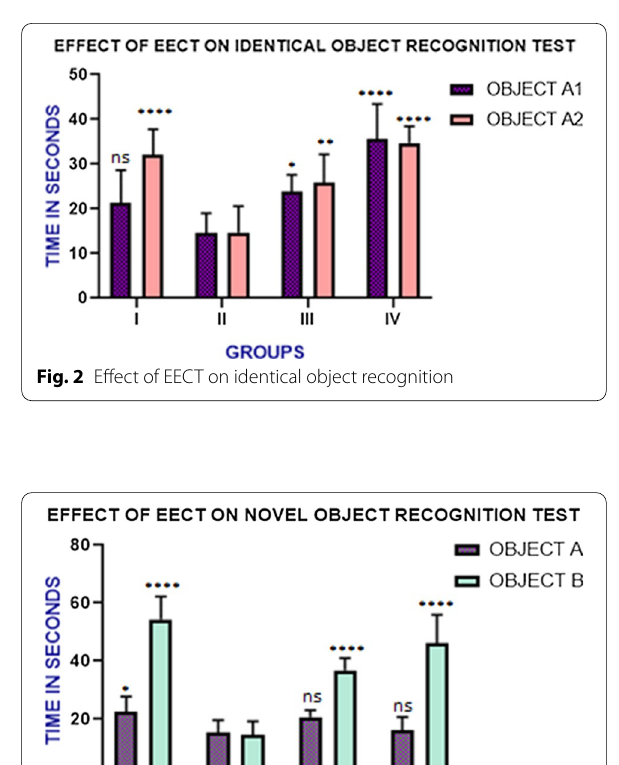
Table 3 Effect of EECT on elevated plus maze